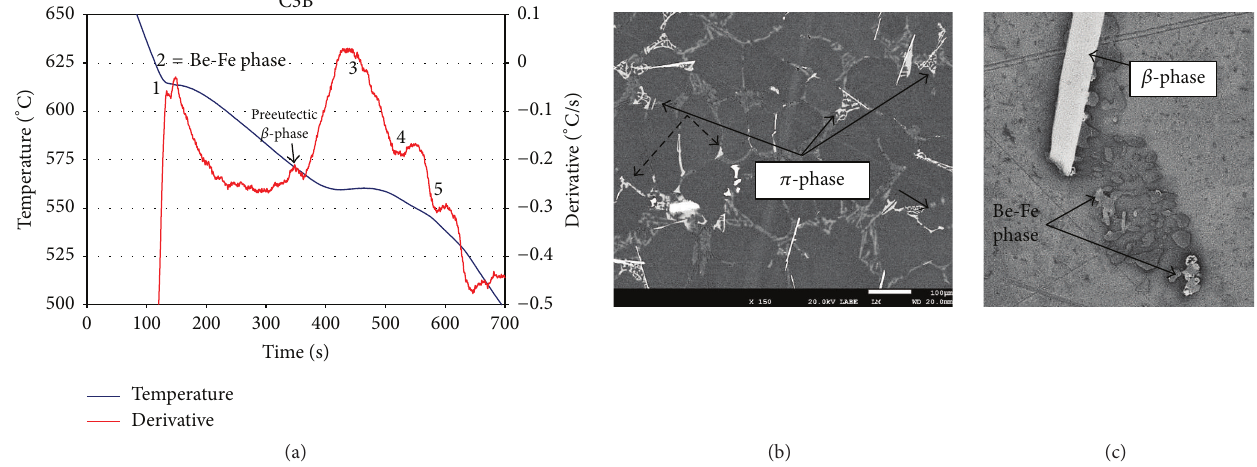
Figure 4: (a) Temperature-time cooling curve and its first derivative obtained from the nonmodified alloy C3B, (b) the corresponding microstructure showing a noticeable larger size of the nodular 𝛽 -Al 5 FeSi phase (broken arrows) and the 𝜋 -Al 8 Mg 3 FeSi 6 phase particles, and (c) enlarged microstructure showing small particles possibly Be-Fe phase and/or 𝜋 -phase particles close to 𝛽 -phase plate-black